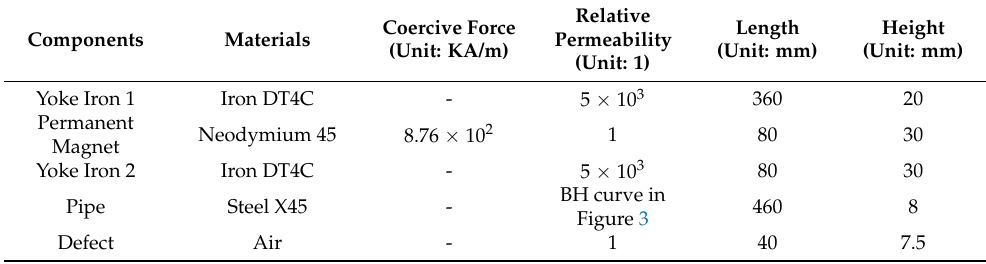
Figure 2. Finite-element model in magnetic flux leakage testing of defects. Figure 2. Finite ‐ element model in magnetic flux leakage testing of defects. Table 1. Properties of the finite-element simulation Figure 2. Finite ‐ element model in magnetic flux leakage testing of defects.